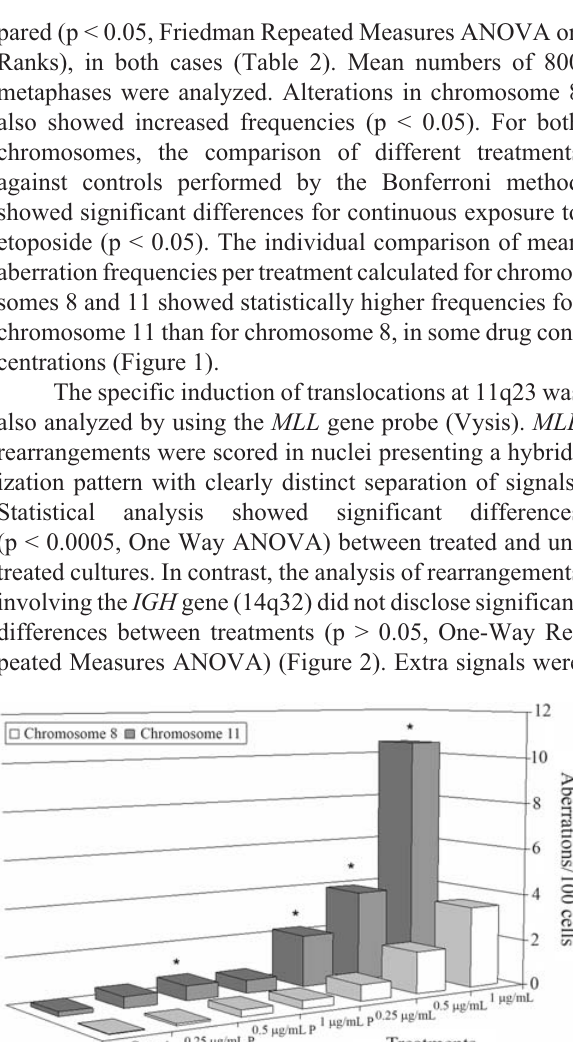
# Chromosome aberrations included chromatidic and chromosome gaps. chromatid and chromosome breaks; fragments. double minutes and other aberrations such as rings. dicentrics. triradial. tetraradial. and complex ab- errations. *Statistically different. p < 0.05. Modality of treatment is indicated in brackets: 1 h pulse and 48 h continu- ous treatment.